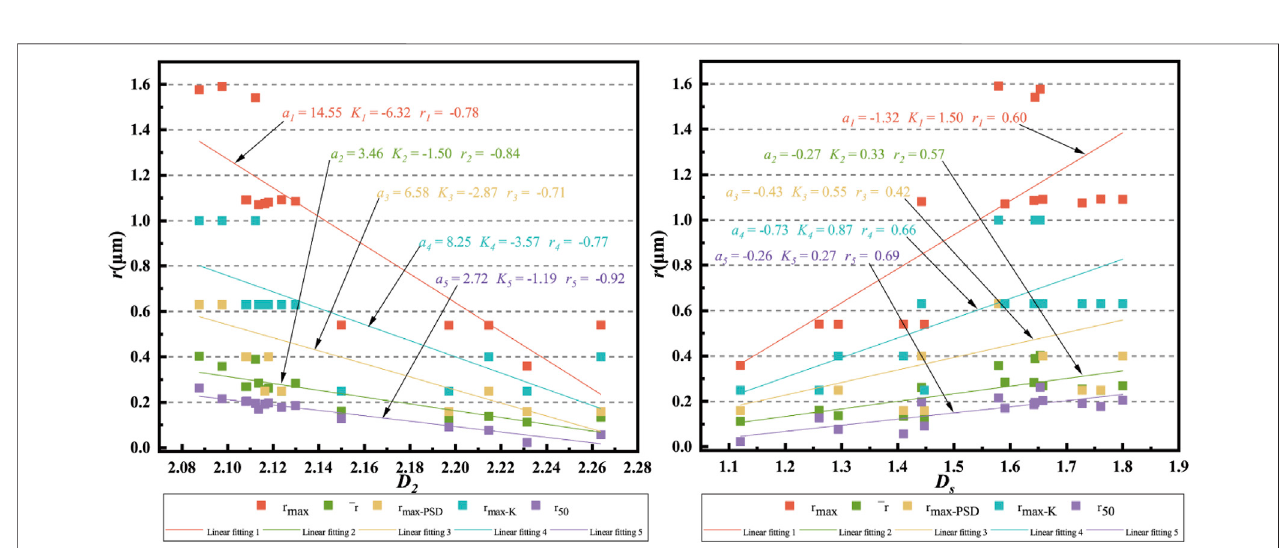
FIGURE 14 | Correlation relationship of 2D and 3D fractal dimension with representative pore/throat-size-related parameters.